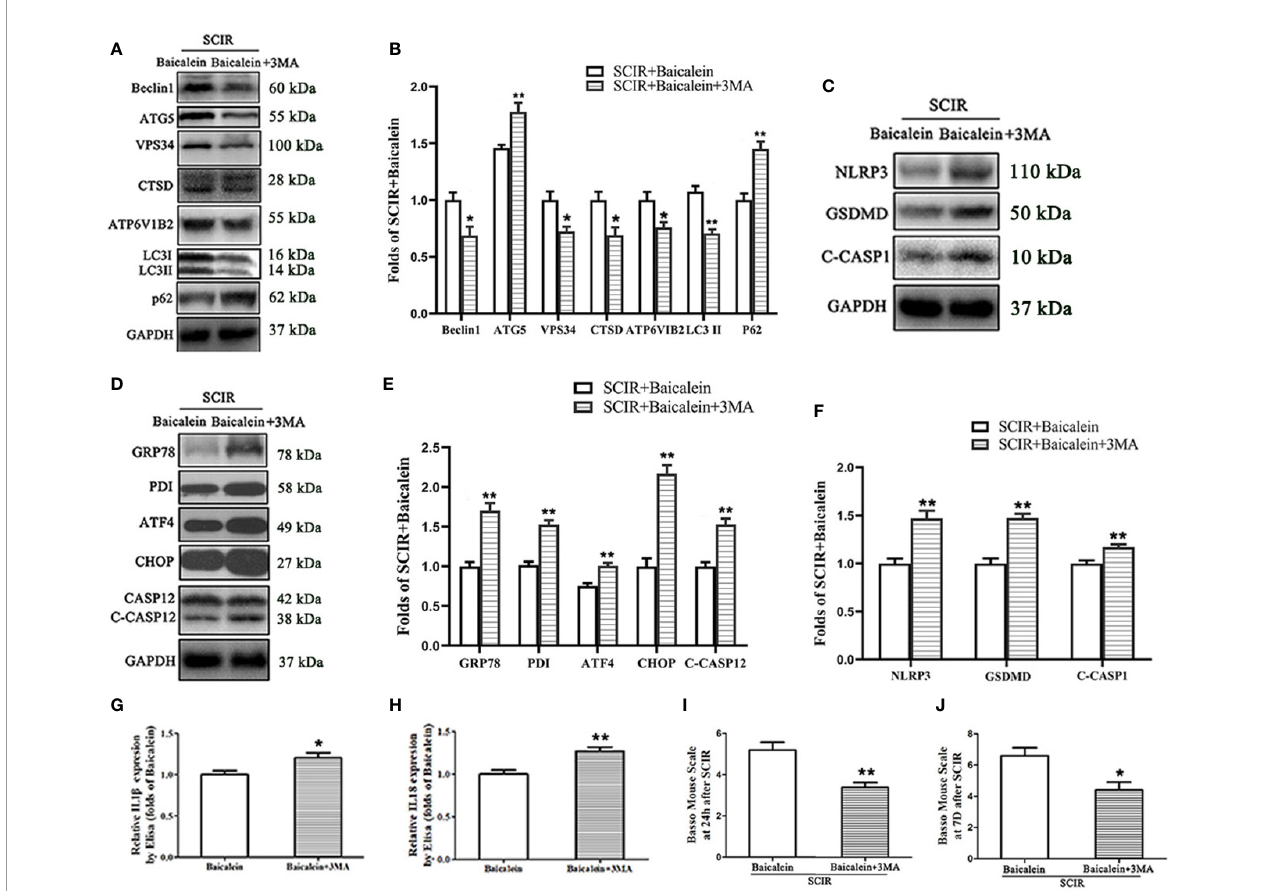
FIGURE 5 | Inhibition of autophagy reverses the effects of baicalein on endoplasmic reticulum (ER) stress, pyroptosis, and functional recovery after SCIR. (A) Western blotting for the Beclin1, ATG5, VPS34, CTSD, ATP6V1B2, LC3II and p62 expression levels in the SCIR+Baicalein, and SCIR+3MA groups. The gels were run under the same experimental conditions, and the cropped blots are shown here. (B) The optical density values of the Beclin1, ATG5, VPS34, CTSD, ATP6V1B2, LC3II and p62 expression levels were quanti fi ed and analyzed in each group. (C, D) Western blotting for the NLRP3, GSDMD, C-CASP1, GRP78, PDI, ATF4, CHOP, and CASP12 expression levels in the SCIR+Baicalein and SCIR+3MA groups. The gels were run under the same experimental conditions, and the cropped blots are shown here. (E, F) The optical density values of GRP78, PDI, ATF4, CHOP, CASP12, NLRP3, GSDM, and C-CASP1expression levels were quanti fi ed and analyzed in the both groups. (G, H) Enzyme-linked immunosorbent assay (ELISA) results for IL1 b and IL18 expression levels in the SCIR+Baicalein and SCIR+3MA groups. (I, J) The BMS scores of the mice in each group at 24 h and 7 days after SCIR. The values are expressed as the means ± SEM, n=5 per group. * p < 0.05 and ** p < 0.01, vs. SCIR+Baicalein